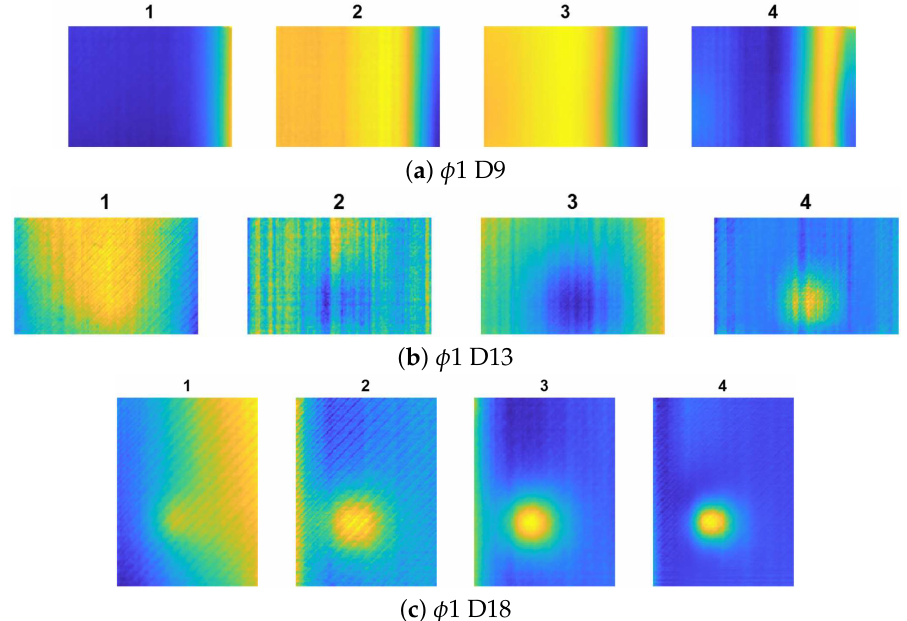
Figure 8. The results of defect visualisation for defects φ 4 and different D values: 1—raw thermogram (captured after the heating phase t = 60 s), 2—chosen result from sequence A I , 3—chosen result from sequence A D , and 4—chosen result from sequence A Res